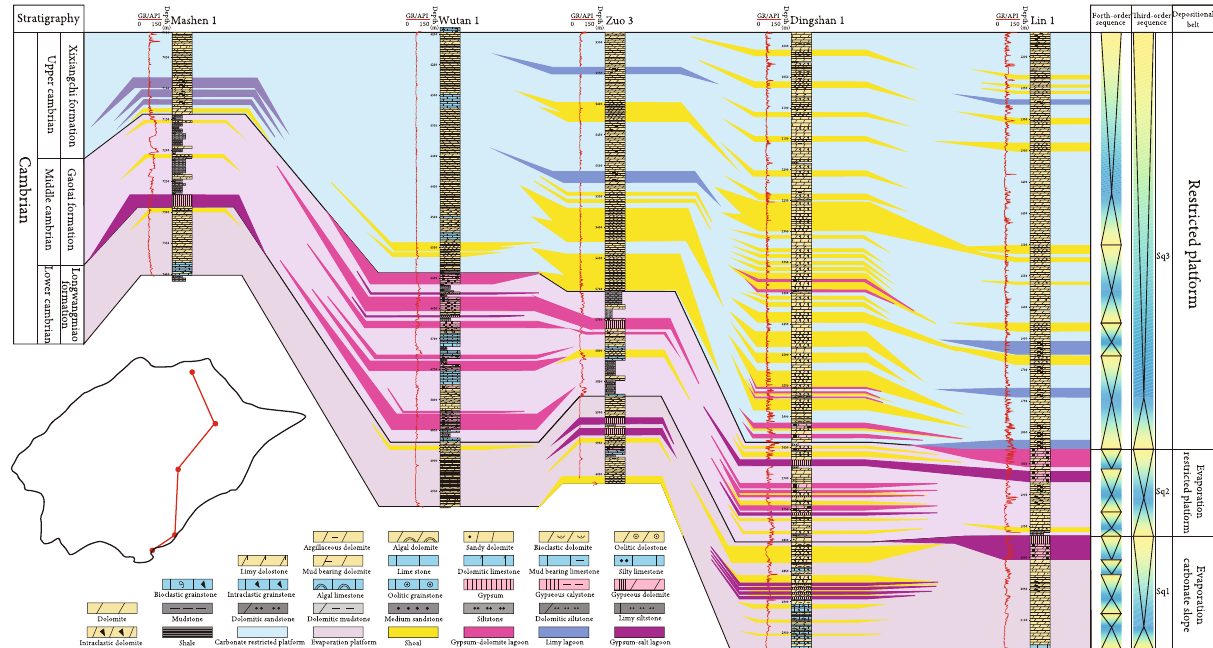
Figure 6: Sedimentary framework pro fi le of the Cambrian DEPS in the Sichuan Basin.